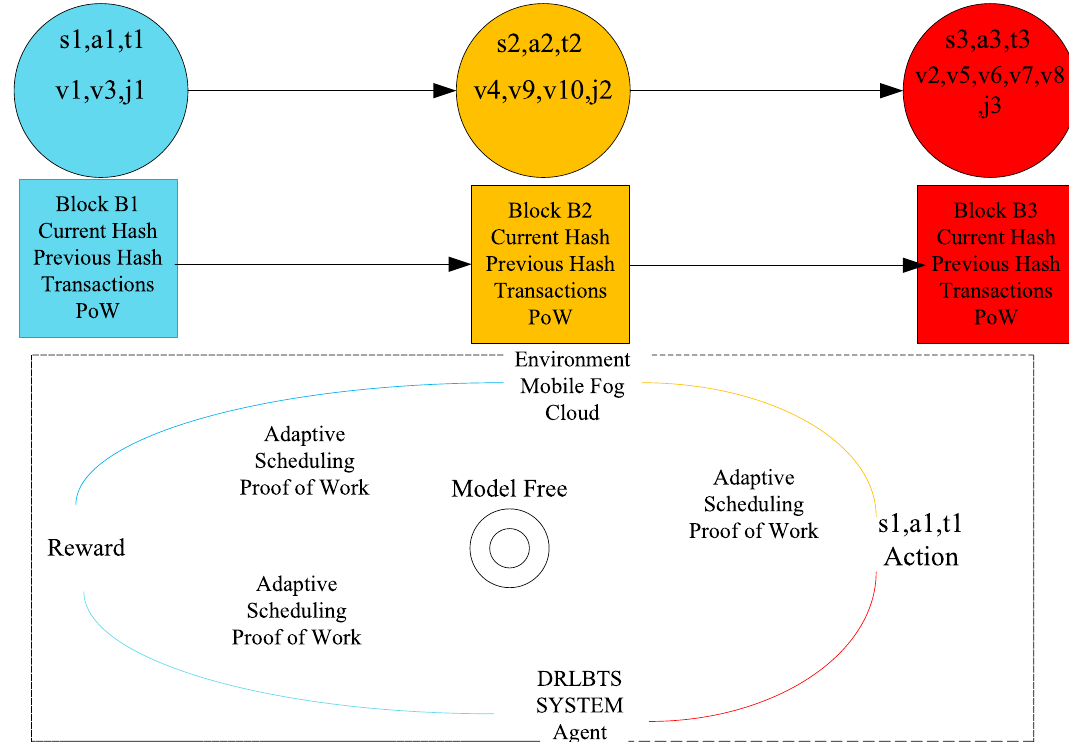
Figure 2. Deep-reinforcement learning-enabled blockchain